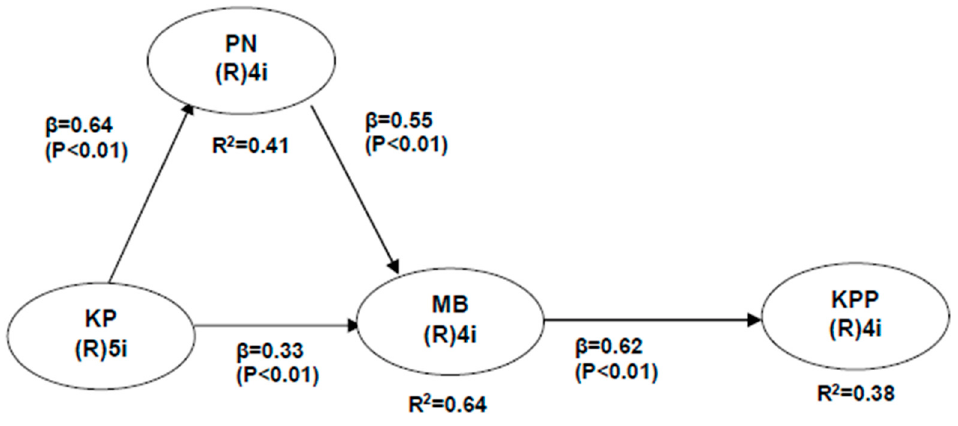
Figure 1. Result of Path Analysis.